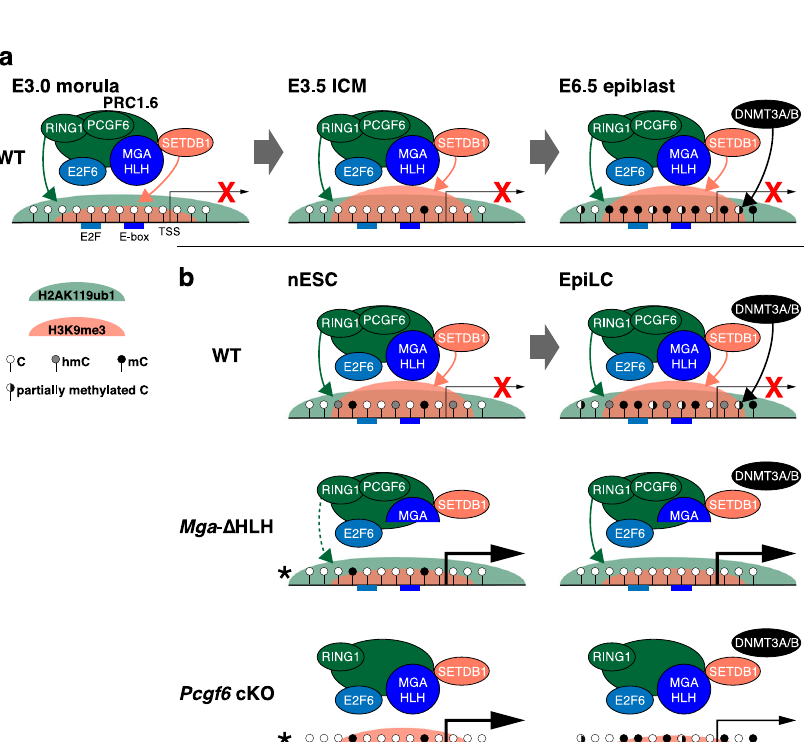
Fig. 6 The order and crosstalk among repressive mechanisms acting at GGD genes during embryogenesis. a The CGI promoter regions of GGD genes with E2F and E-box motifs are bound by MGA and E2F6 (as determined in ESCs). Prior to implantation (E3.5 ICM), these GGD genes are sequentially marked by H2AK119ub1, dependent in part upon PRC1.6, H3K9me3, dependent upon SETDB1 and H3K27me3, dependent upon PRC2 (not shown). DNMT3A/3B-dependent de novo DNAme occurs at these regions only after implantation (~E6.5 epiblast) and accumulates further thereafter. Single- nucleotide resolution data for hmC has not been determined in ICM or epiblast. MGA/PRC1.6 binding may be disrupted once the CpG site embedded within the E-box motif is methylated (not shown), leaving DNAme as the only repressive mark. b In vitro modeling of this transition recapitulates H3K9me3 and H2AK119ub1 enrichment, as well as de novo DNAme of these promoter regions following induction of EpiLCs from nESCs. While nESCs show lower levels of DNAme than EpiLCs, hmC levels at GGD gene promoters are detected at similar levels in both cell types, likely re fl ecting TET1 activity (not shown). The absence of the bHLHZ DNA-binding domain of MGA ( Mga - Δ HLH) is associated with a reduction of H3K9me3 at these loci in nESCs and disruption of de novo DNAme following EpiLCs induction. PCGF6, a subunit of PRC1.6 is required for ef fi cient deposition of H3K9me3 as well as H2AK119ub1 in nESCs and EpiLCs, but its deletion has only a modest impact on de novo DNAme in EpiLCs relative to Mga - Δ HLH. Germline genes are derepressed to a greater extent in Pcgf6 cKO nESCs than EpiLCs, perhaps due to the accumulation of DNAme in the latter. * The status of mC and hmC of GGD gene promoters was not determined in Mga - Δ HLH or Pcgf6 cKO nESCs. Setdb1 and Ring1b Double KO also leads to robust derepression of GGD genes in nESCs (not shown), con fi rming the importance of both H3K9me3 and H2AK119ub1 in their transcriptional repression prior to the onset of de novo sequential accumulation of H2AK119ub1, H3K9me3, and H3K27me3, followed by de novo DNAme in the epiblast (Fig. 6a).